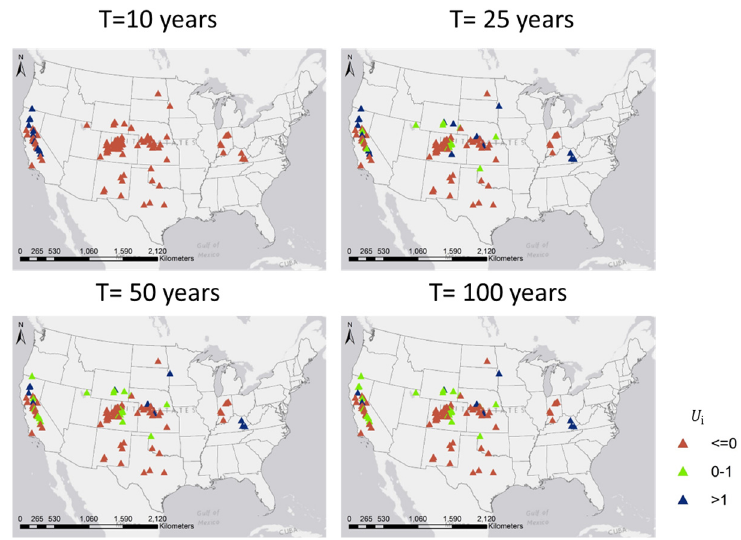
Figure 5. The expansion usefulness metrics of reservoir.